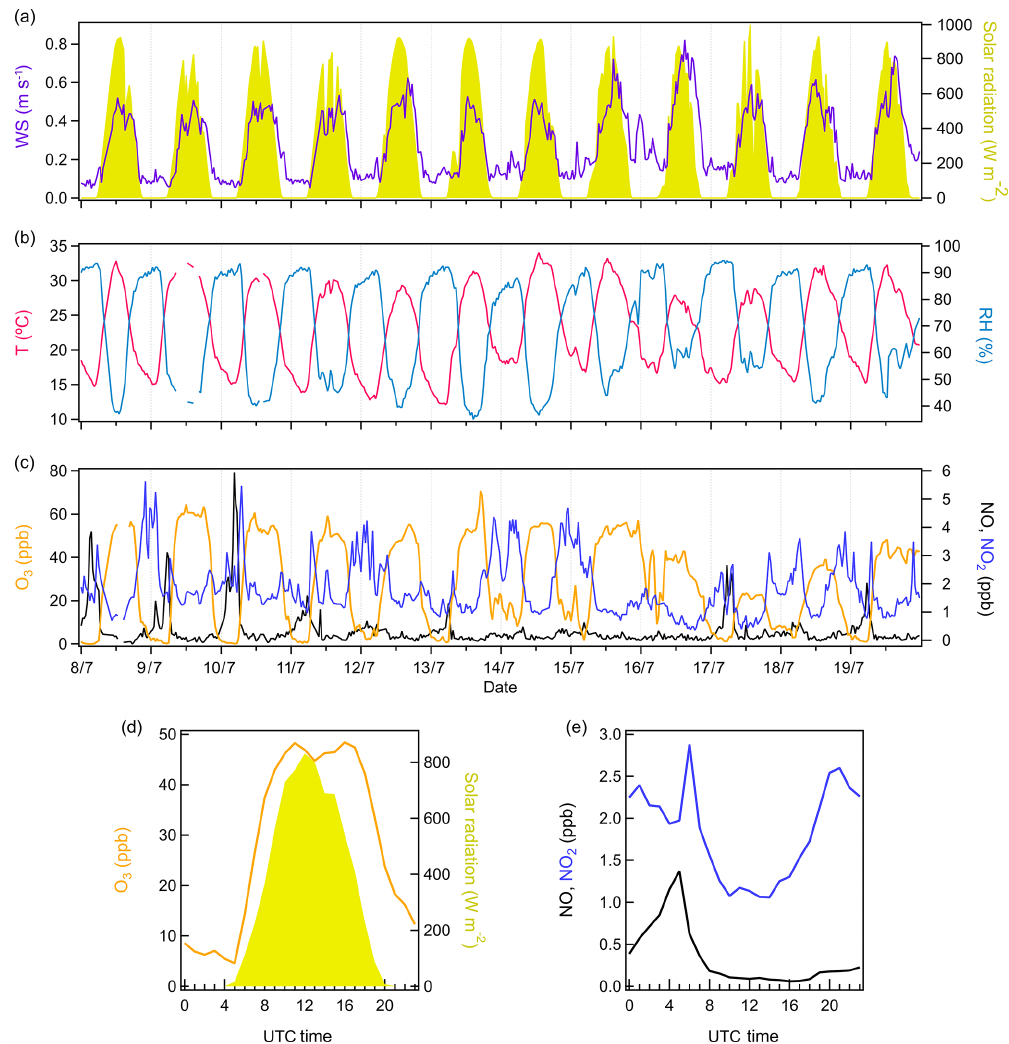
Figure 1. Variations of meteorological conditions and trace gases. (a) Time series of wind speed and solar radiation. (b) Time series of temperature and relative humidity. (c) Time series of O 3 , NO, and NO 2 . (d) Diurnal cycles of O 3 and solar radiation. (e) Diurnal cycles of NO and NO 2